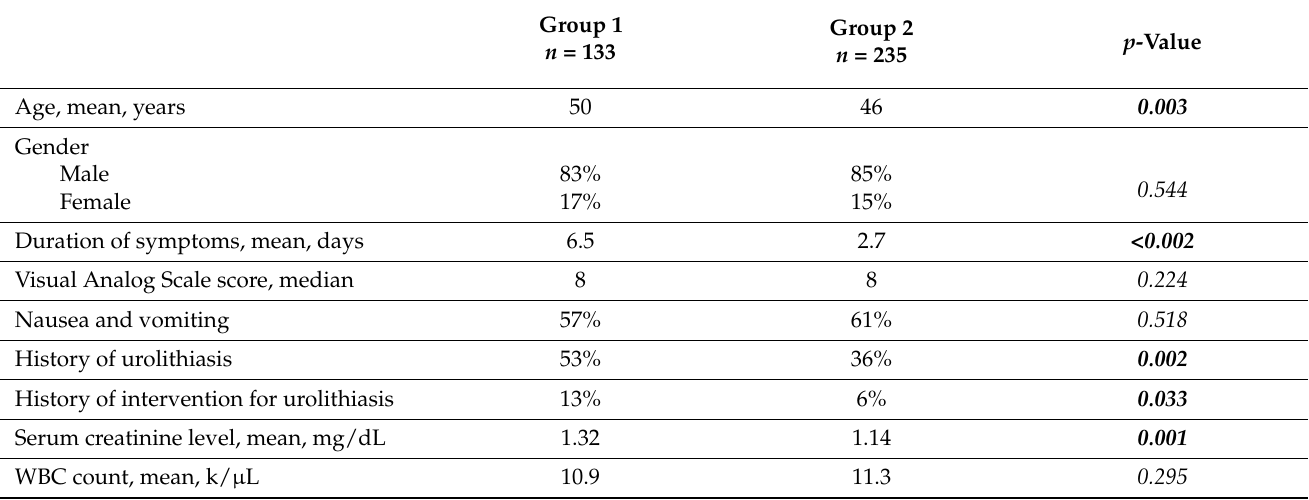
Table 2. Baseline characteristics of patients who required surgical intervention (Group 1) vs. pa- tients who were successfully treated conservatively (Group 2). Boldface indicates statistically significant factors.